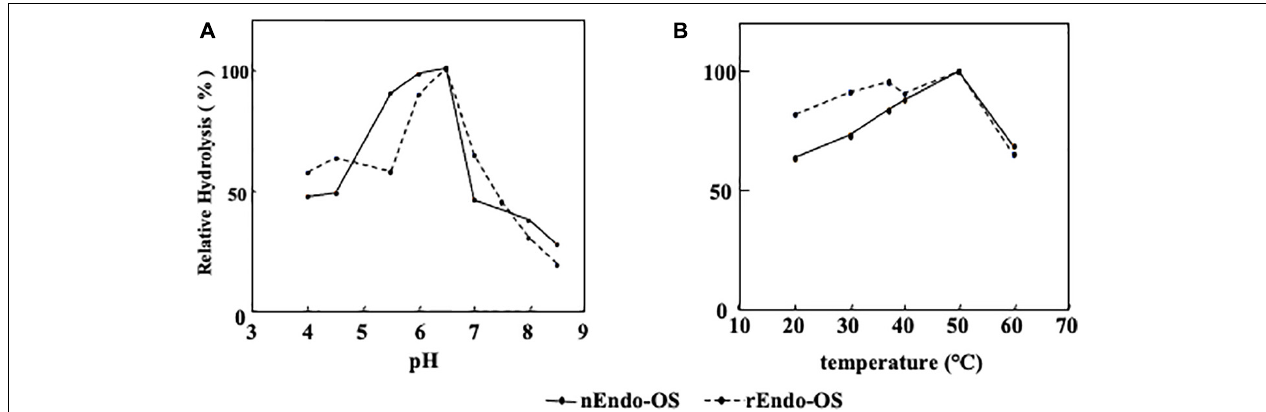
FIGURE 5 | Effects of pH and temperature on Endo-Os activity. Optimum pH and temperature were determined using M6B as a substrate and M3FX as an internal standard. (A) Optimum pH was determined after incubation in buffers with various pH (0.1 M MES buffer for pH 4.0–6.5 and 0.1 M HEPES buffer for pH 7.0–8.5) at 37 ◦ C for 30 min. (B) Optimum temperature was determined after incubation in 0.5 M MES buffer at pH 6.0, containing 10 mM of EDTA at various temperatures for 30 min.